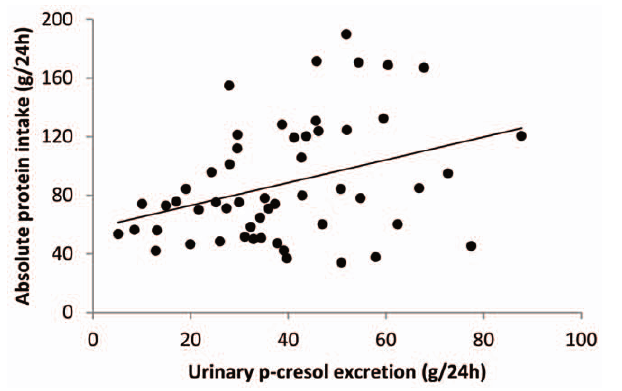
Figure 3. Scatter plot of the comparison between urinary p- cresol excretion (mg/24 h) and absolute protein intake (g/ 24 h). Urinary p-cresol excretion correlated positively with absolute protein intake (Spearman’s r=0.371, p=0.007).